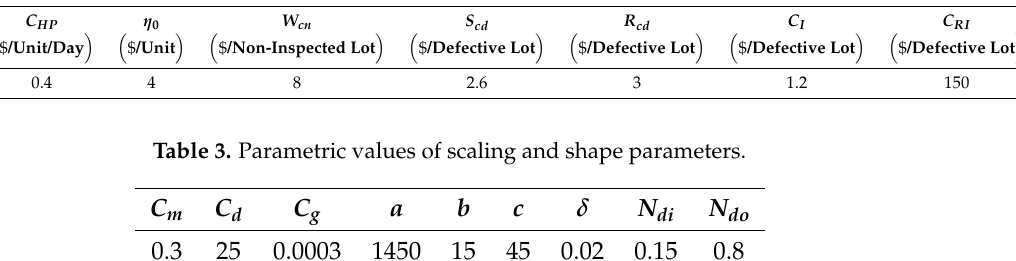
Table 2. Parametric values of different cost parameters.